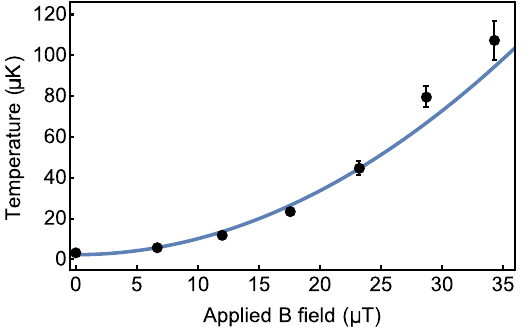
Figure 4. Molasses temperature measured as a function of the applied static field with best fitting curve.